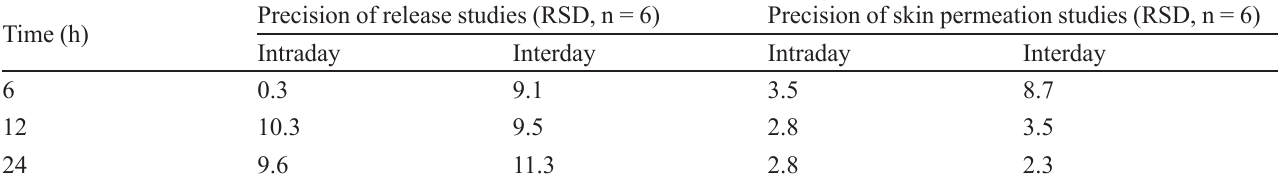
TABLE III - Precision of in vitro performance studies Time